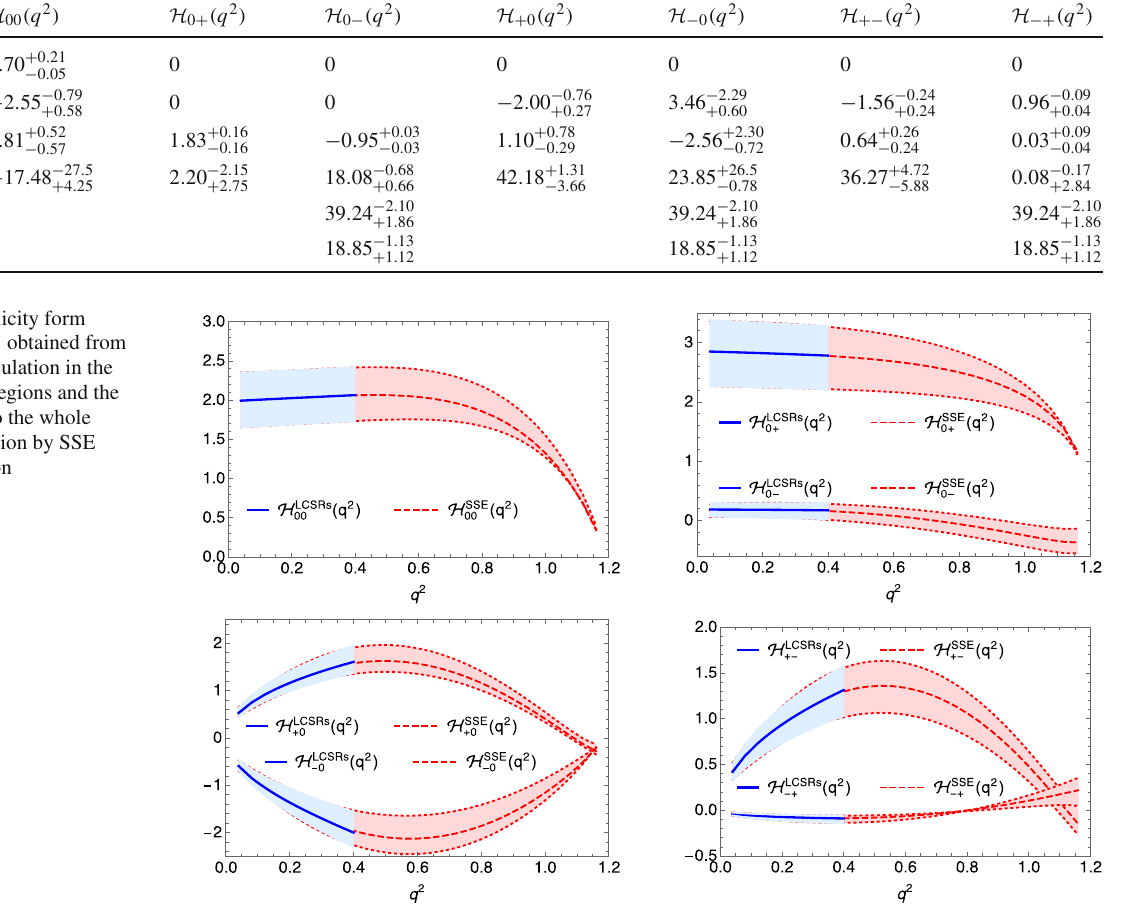
Table 3 The SSE parameters of the helicity form factors H ij ( q 2 ) Para.